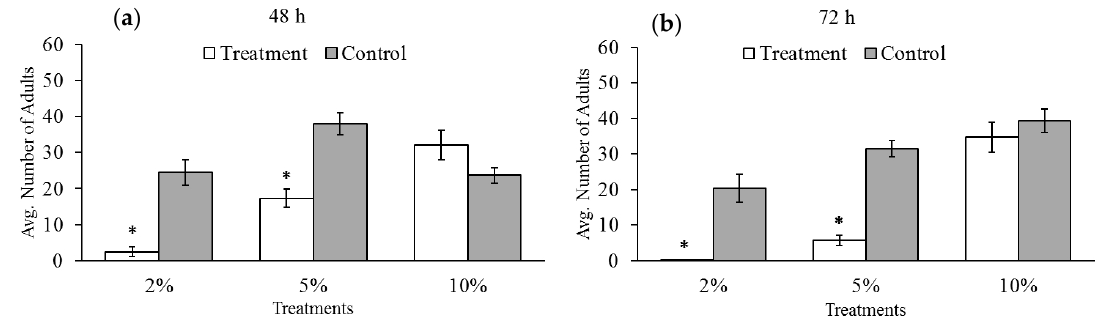
Figure 3. Average number of progeny emerged from bruchid eggs laid by female bruchids exposed to low oxygen for ( a ) 48 and ( b ) 72 h and under normal oxygen. Asterisks represent statistically significant differences between oxygen treatment groups (white) and paired control groups (gray). Bars with no asterisk were not significantly different from the control group. The 2% and 5% oxygen treatments significantly reduced progeny development, while 10% oxygen did not result in the same effect.